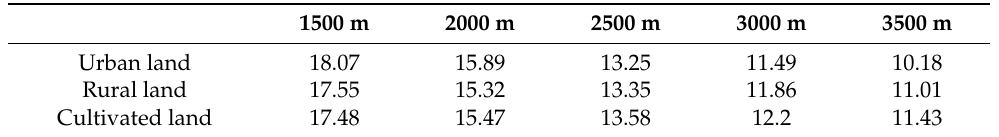
Table 3. Comparison of LST ( ◦ C) of urban, rural, and cultivated land at elevations of 1500 m, 2000 m, 2500 m, 3000 m, and 3500